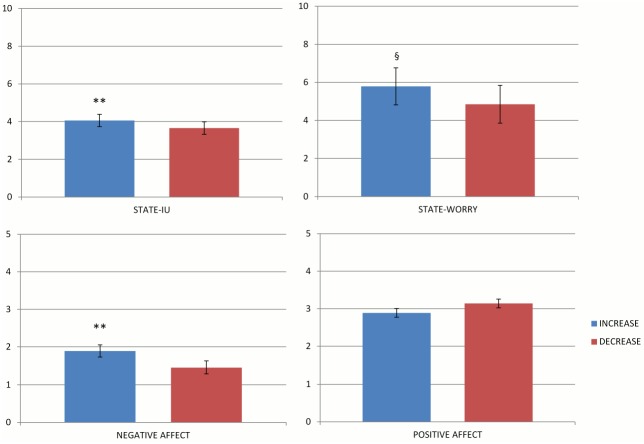
ANCOVA by condition.